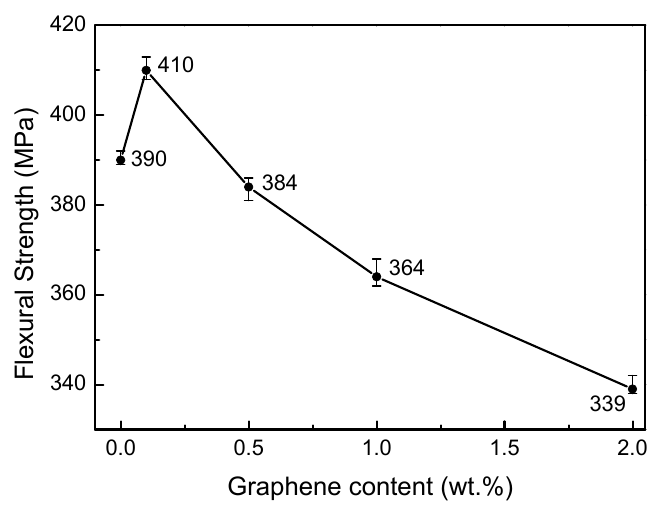
Figure 1. Effect of graphene doping on flexural strength of SiC ceramics. Figure 1. E ff ect of graphene doping on flexural strength of SiC